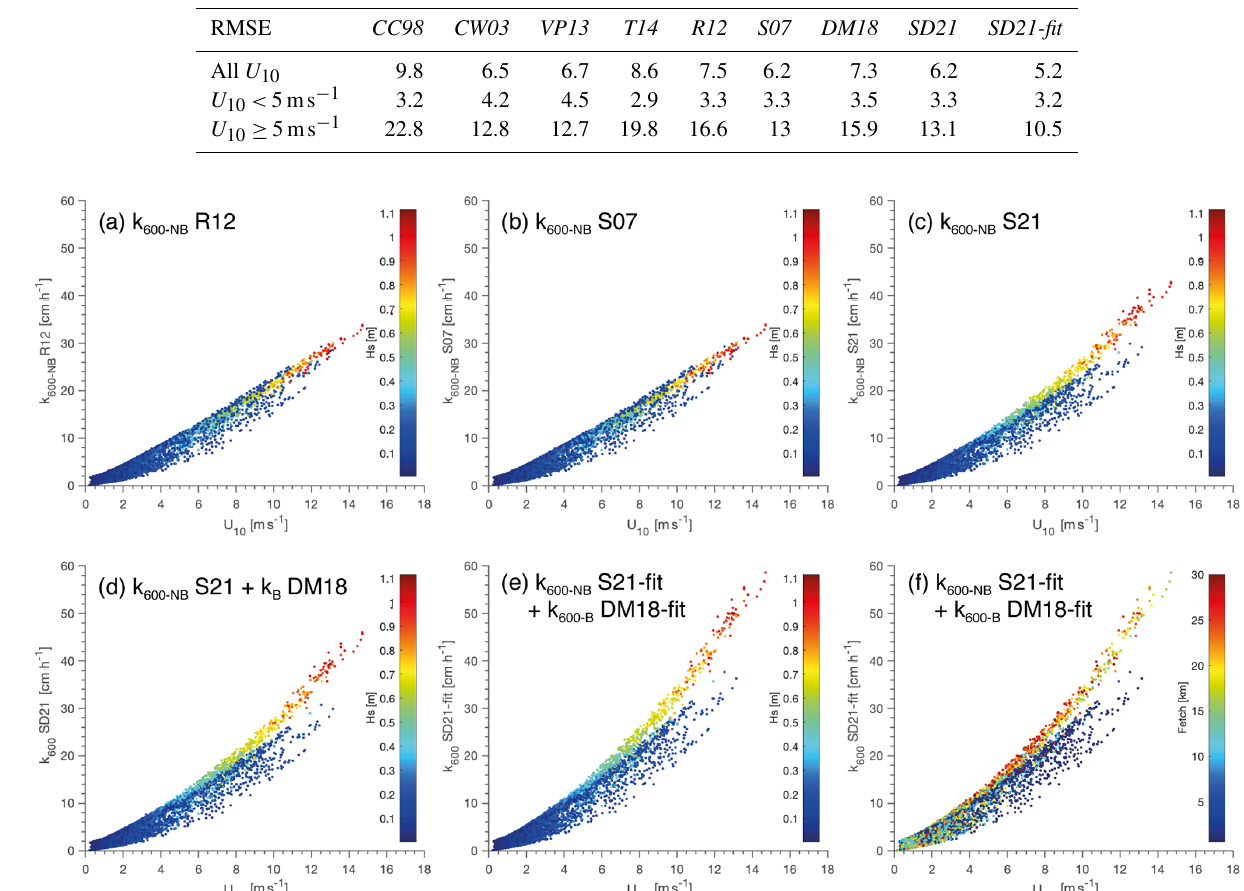
Table 2. RMSE of k 600 models for all wind speed ( U 10 ), U 10 < 5ms − 1 (i.e. LW), and U 10 ≥ 5ms − 1 (i.e. SW).